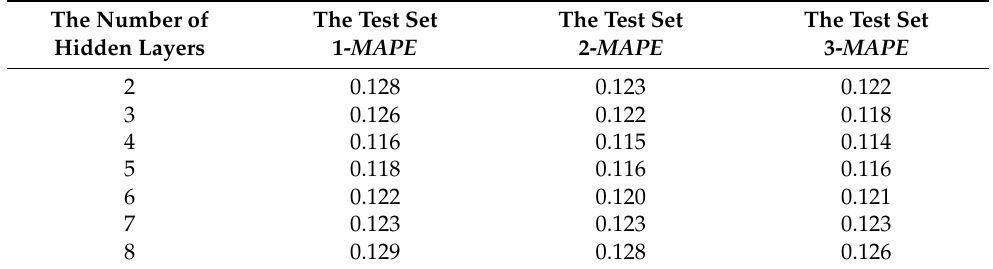
Table 3. The effect of the choice of the number of hidden layers on the prediction effect of the model.